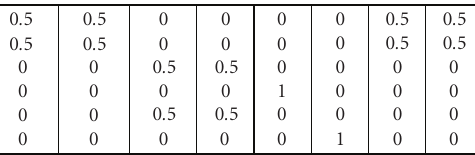
Figure 8: Reconstructed X .